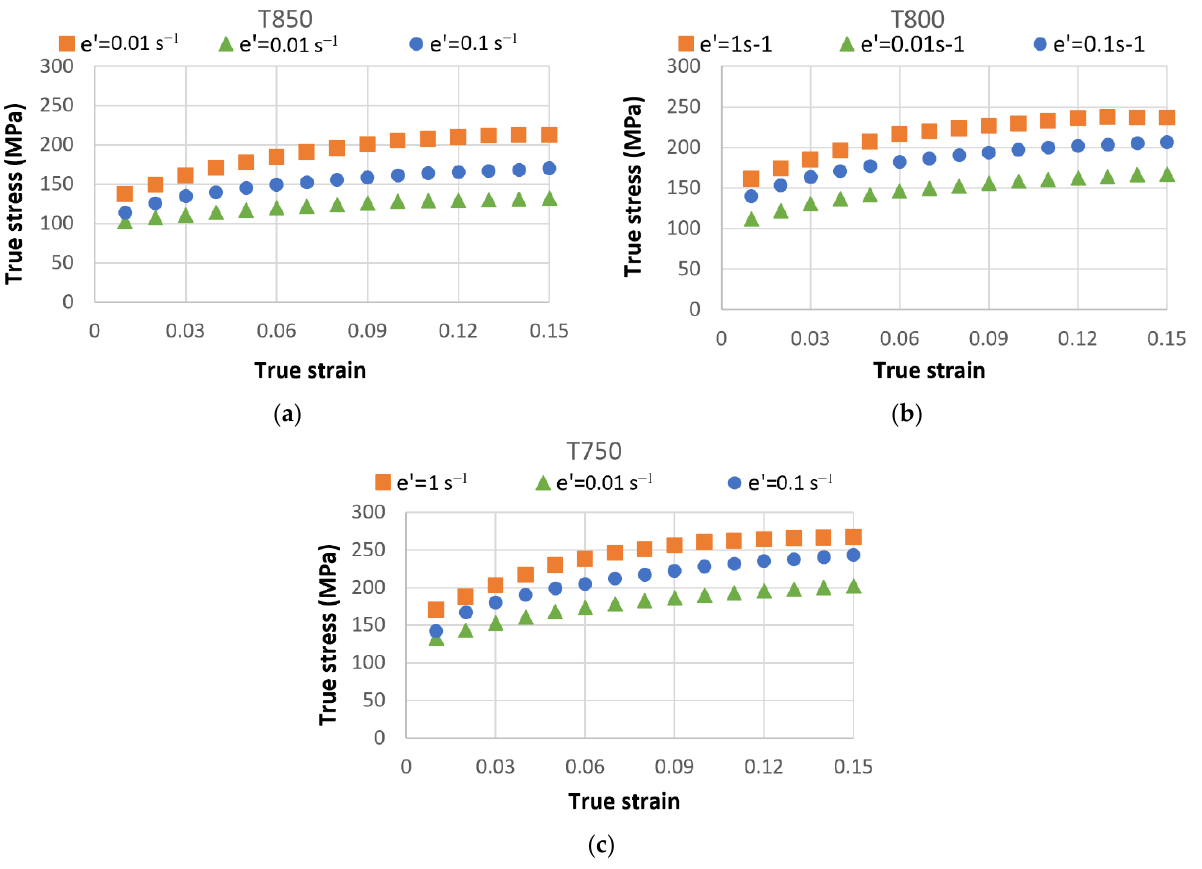
Figure 17. True stress – strain curves of USIBOR ® 2000 steel under different strain rates (1 s −1 , 0.1 s −1 , 0.01 s −1 ) for different test temperatures: ( a ) 850 °C, ( b ) 800 °C, ( c ) 750 °C.